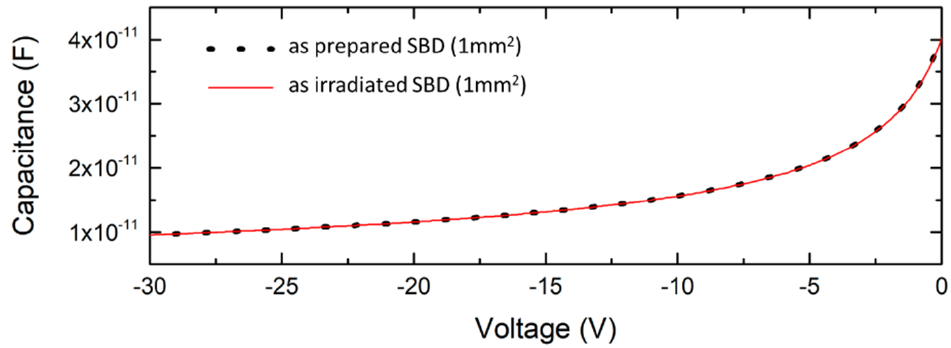
Figure 3. C-V measurements at RT of 4H-SiC SBD before and after the alpha particle radiation tests. Data adapted from Ref. [9].